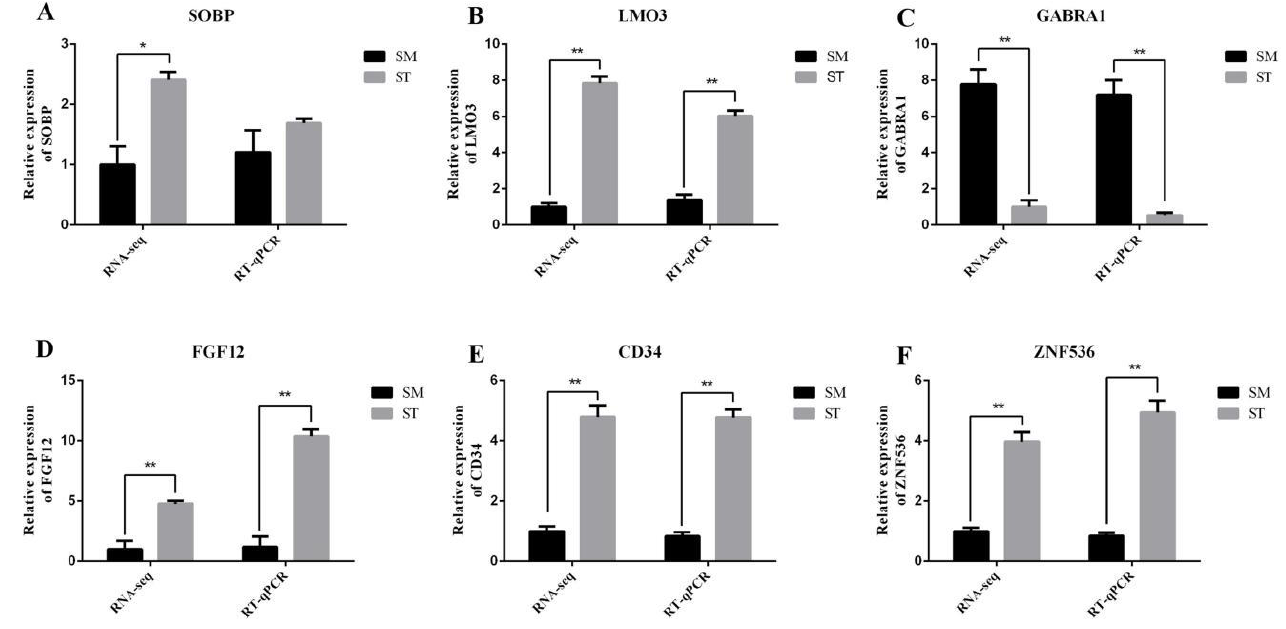
Figure 8. Verification of mRNAs sequencing by RT-qPCR between SM and ST. ( A ) Relative expression of SOBP mRNA. ( B ) Relative expression of LMO3 mRNA. ( C ) Relative expression of GABRA1 mRNA. ( D ) Relative expression of FGF12 mRNA. ( E ) Relative expression of CD34 mRNA. ( F ) Relative expression of ZNF536 mRNA. * represents statistical significance ( p < 0.05) and ** represents extremely significant difference ( p < 0.01).